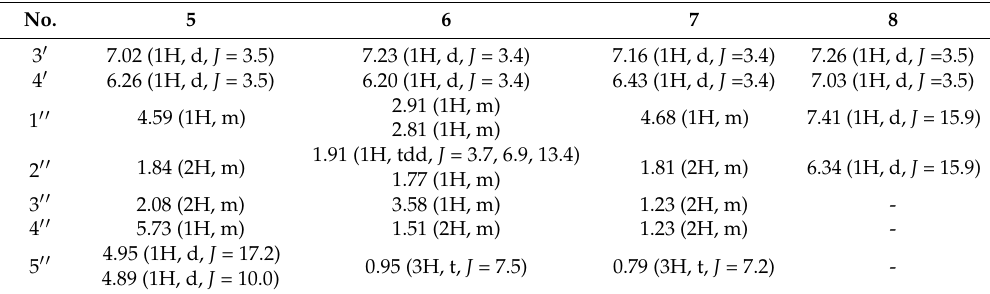
Table 3. 1 H-NMR data for 5 – 8 ( 5 and 6 in CDCl 3 , 7 in CD 3 OD, 8 in DMSO- d 6 , 500 MHz, J in Hz, δ in